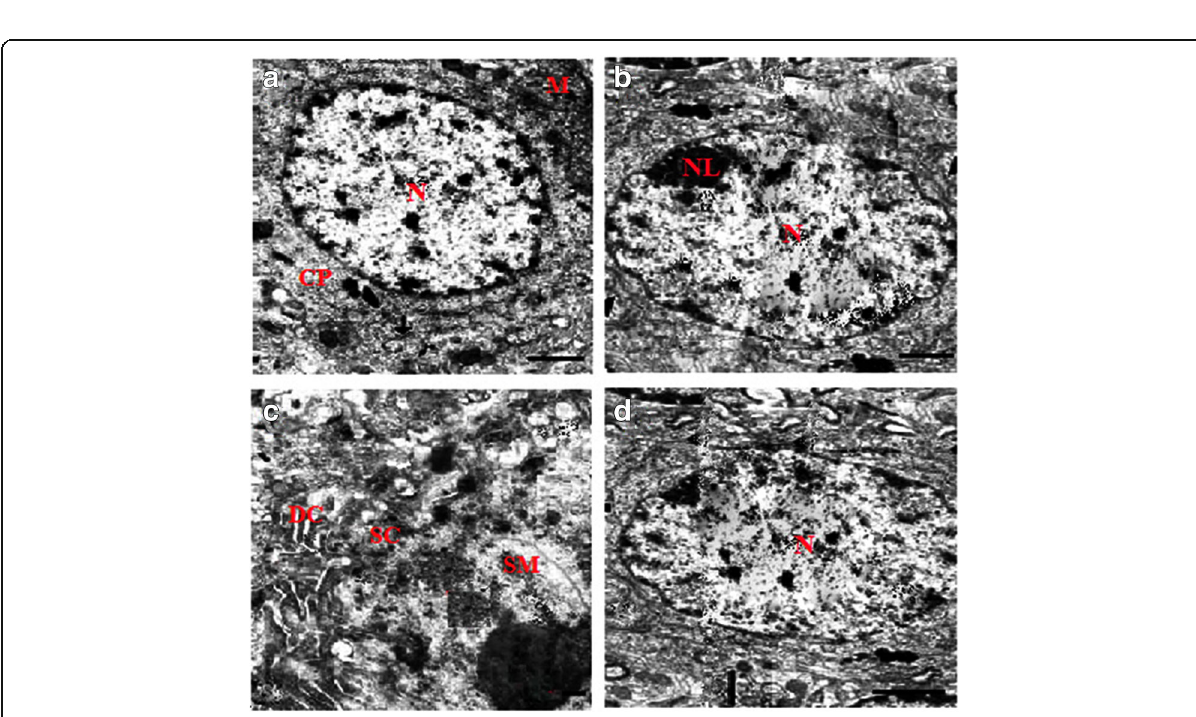
Fig. 14 Effect of EGCG on Fl induced ultra changes in the hippocampus by transmission of electron microphotographs in the hippocampus of control and experimental animals ( a – d ). a Control rats: normal neurons are shown condensed, regularly shaped, round nucleous (N) and nucleoulus (NL) in normal cells. b EGCG-treated rats: the ultrastructure of cytoplasm (CP) and cytoplasmic organelles showed a normal appearance of nucleous (N), mitochondria (M), and nucleoulus (NL). c Fl-treated rats: disintegrating neuron containing shrunken cytoplasm (SC), slightly dilated cisternae (DC) of endoplasmic reticulum and swollen mitochondria (SM) were observed. Typical necrotic neurons had smaller clumps of irregularly shaped, condensed chromatin with nuclear membrane breakdown. d Fl-treated rats with EGCG: EGCG treatment was effectively preventing the abovementioned findings, compared to control (NL: nucleolus, N: nucleus, CP: cytoplasm, DC: dilated cisternae SC: shrunken cytoplasm, SM: swollen mitochondria (scale bars, 1 μ